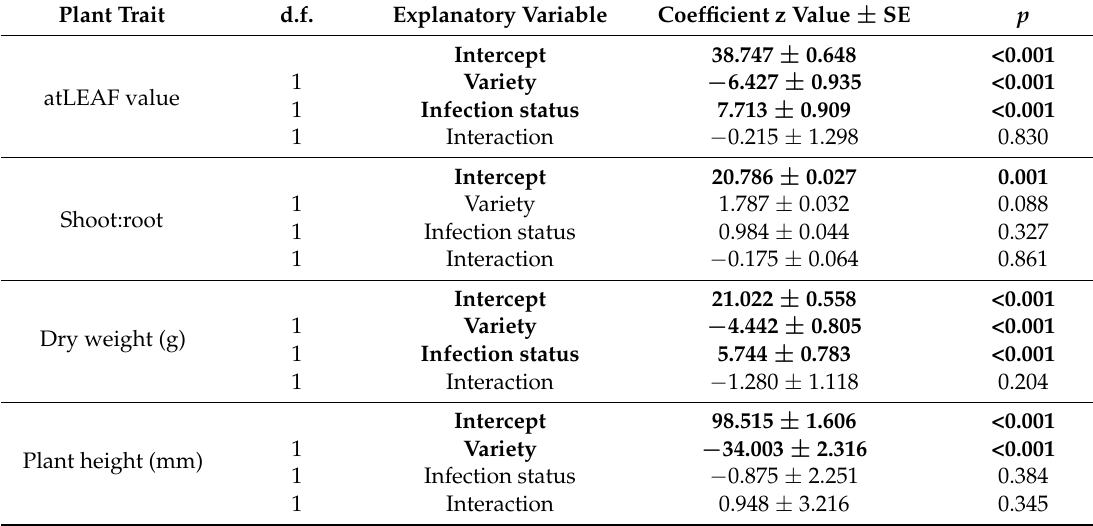
Table 1. Summary of effects of asymptomatic B. cinerea infection status and plant variety on plant traits following analysis. Significant values are in